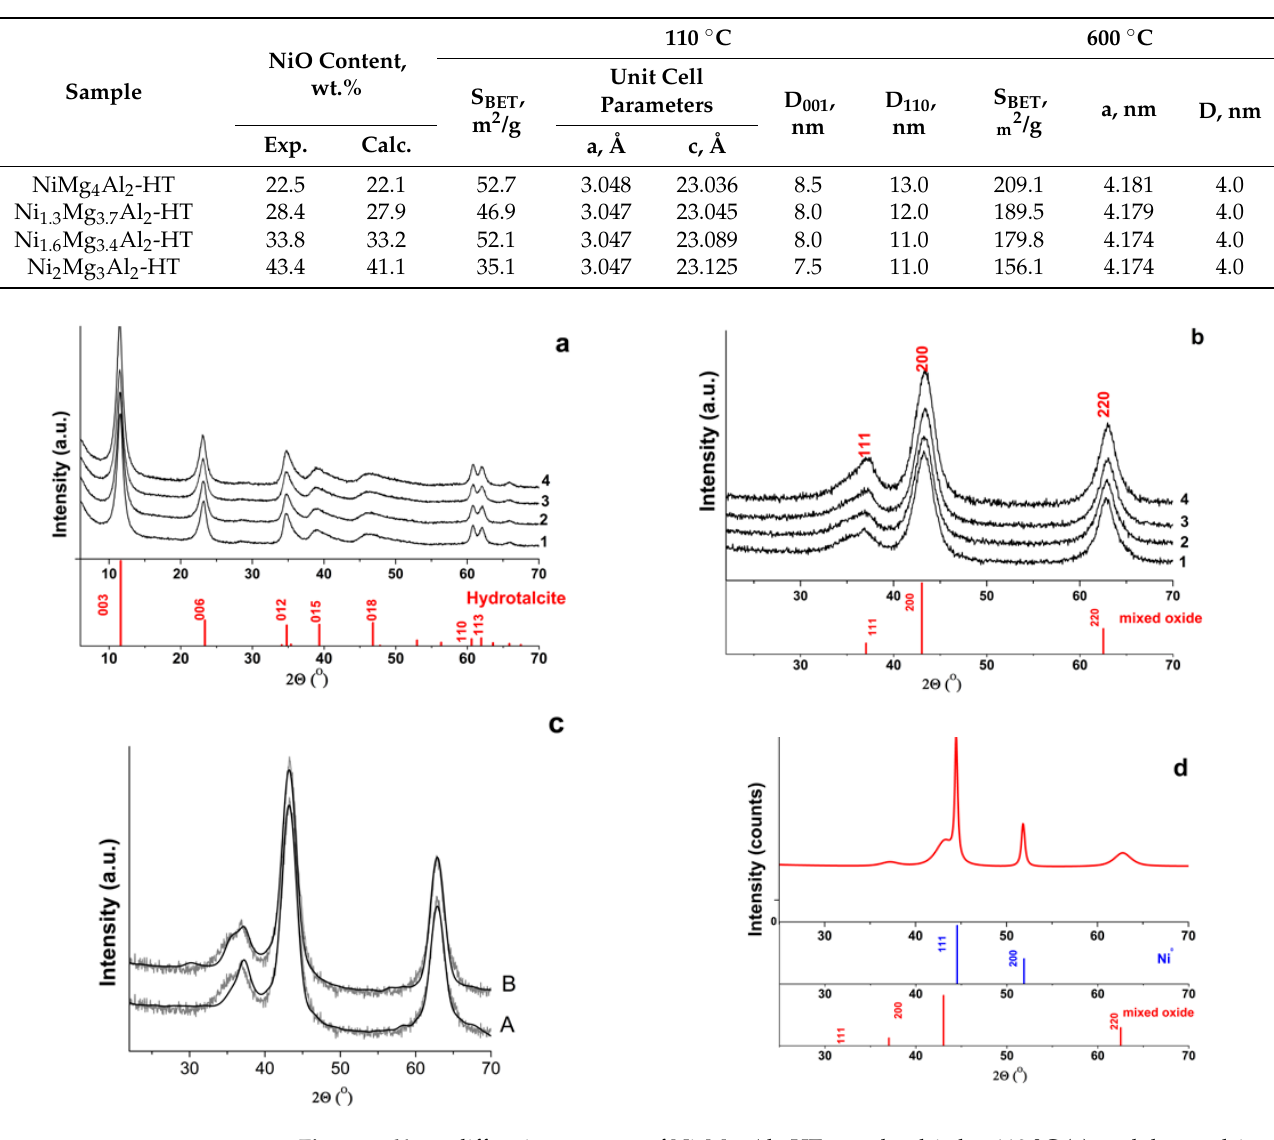
Figure 1. X-ray diffraction patterns of Ni x Mg y Al 2 -HT samples dried at 110 ◦ C ( a ), and those calcined at 600 ◦ C ( b ), experimental XRD pattern for NiMg 4 Al 2 -HT sample (gray curves) and calculated XRD patterns (black curves) for models of Ni-Mg-Al oxide nanoparticle with a cubic NaCl-type structure (A) and Ni-Mg-Al oxide nanoparticle, 50% of which are NaCl-like layers and 50% of which are spinel-like layers (B) ( c ), and Ni 1.6 Mg 3.4 Al 2 -HT sample reduced in H 2 at 700 ◦ C ( d ) (1—NiMg 4 Al 2